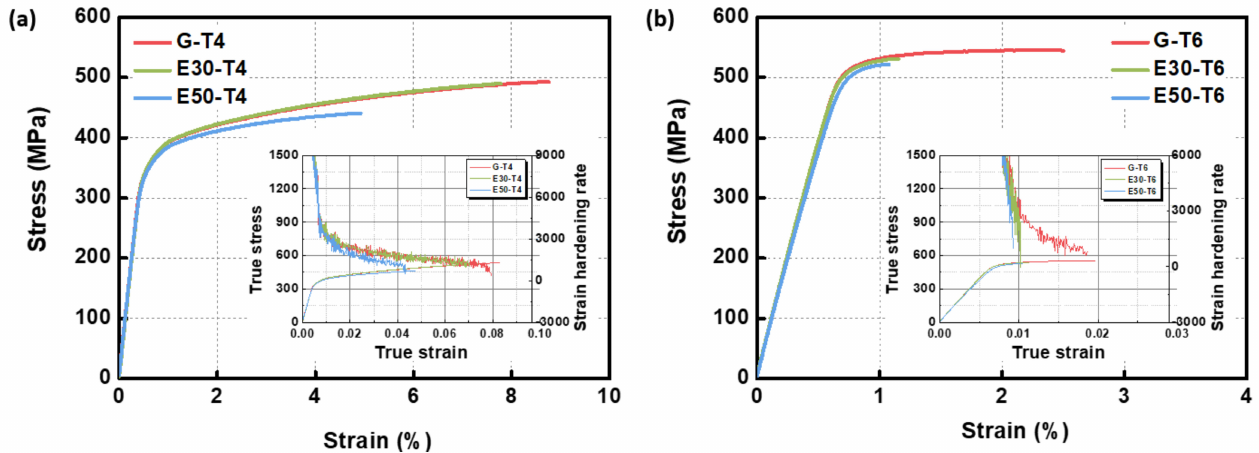
Figure 4. Engineering and true stress–strain and strain-hardening rate curves of the ( a ) G-T4, E30-T4, and E50-T4 specimens and ( b ) G-T6, E30-T6, and E50-T6 specimens. Table 3. Tensile properties of GBF- and EMS-processed specimens of as-cast, T4, and T6 heat treatment